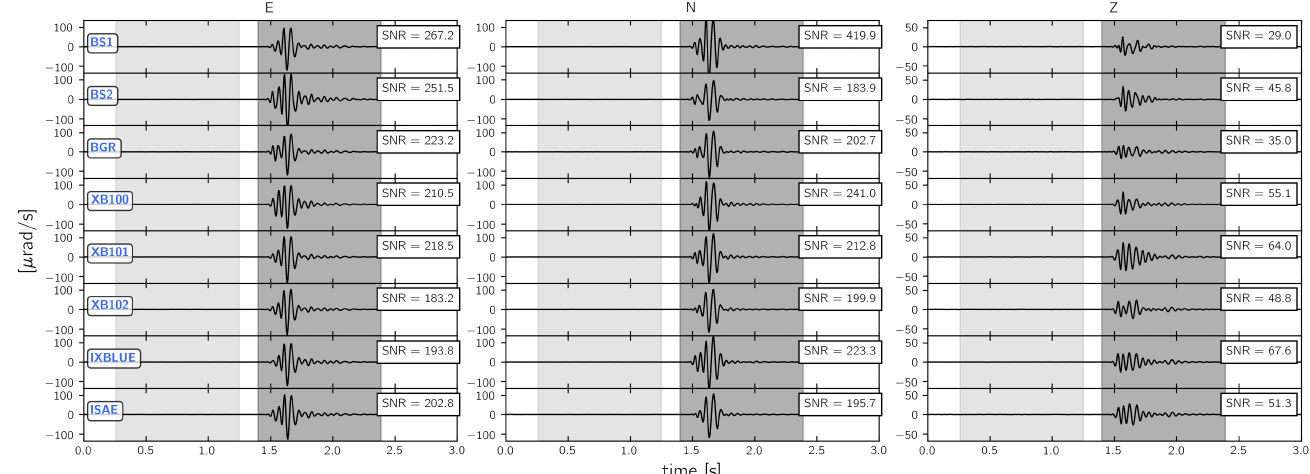
Figure 9. 30Hz low pass filtered waveforms from the explosion “expl2” (see Figure 1) recorded by 3C rotational seismome- ters. The light and dark shaded areas represent the parts of the time series from which noise root-mean-square (RMS) and signal RMS values are calculated, respectively. The obtained signal-to-noise ratios (SNR) are given for each instrument and each axis in the black box.